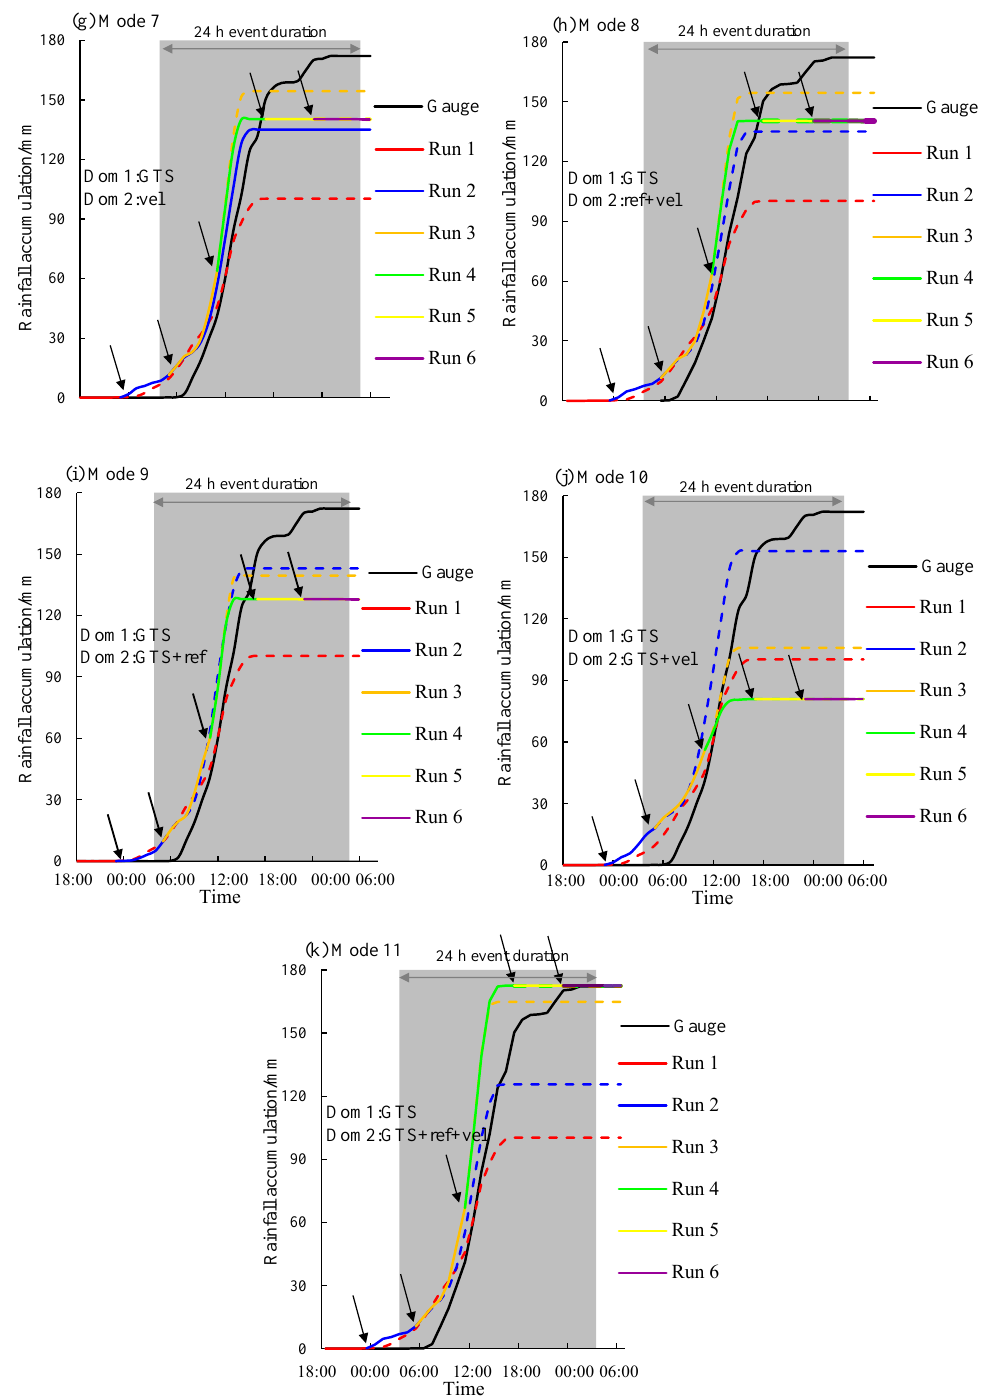
Figure 5. Cumulative hyetographs for the 11 data assimilation